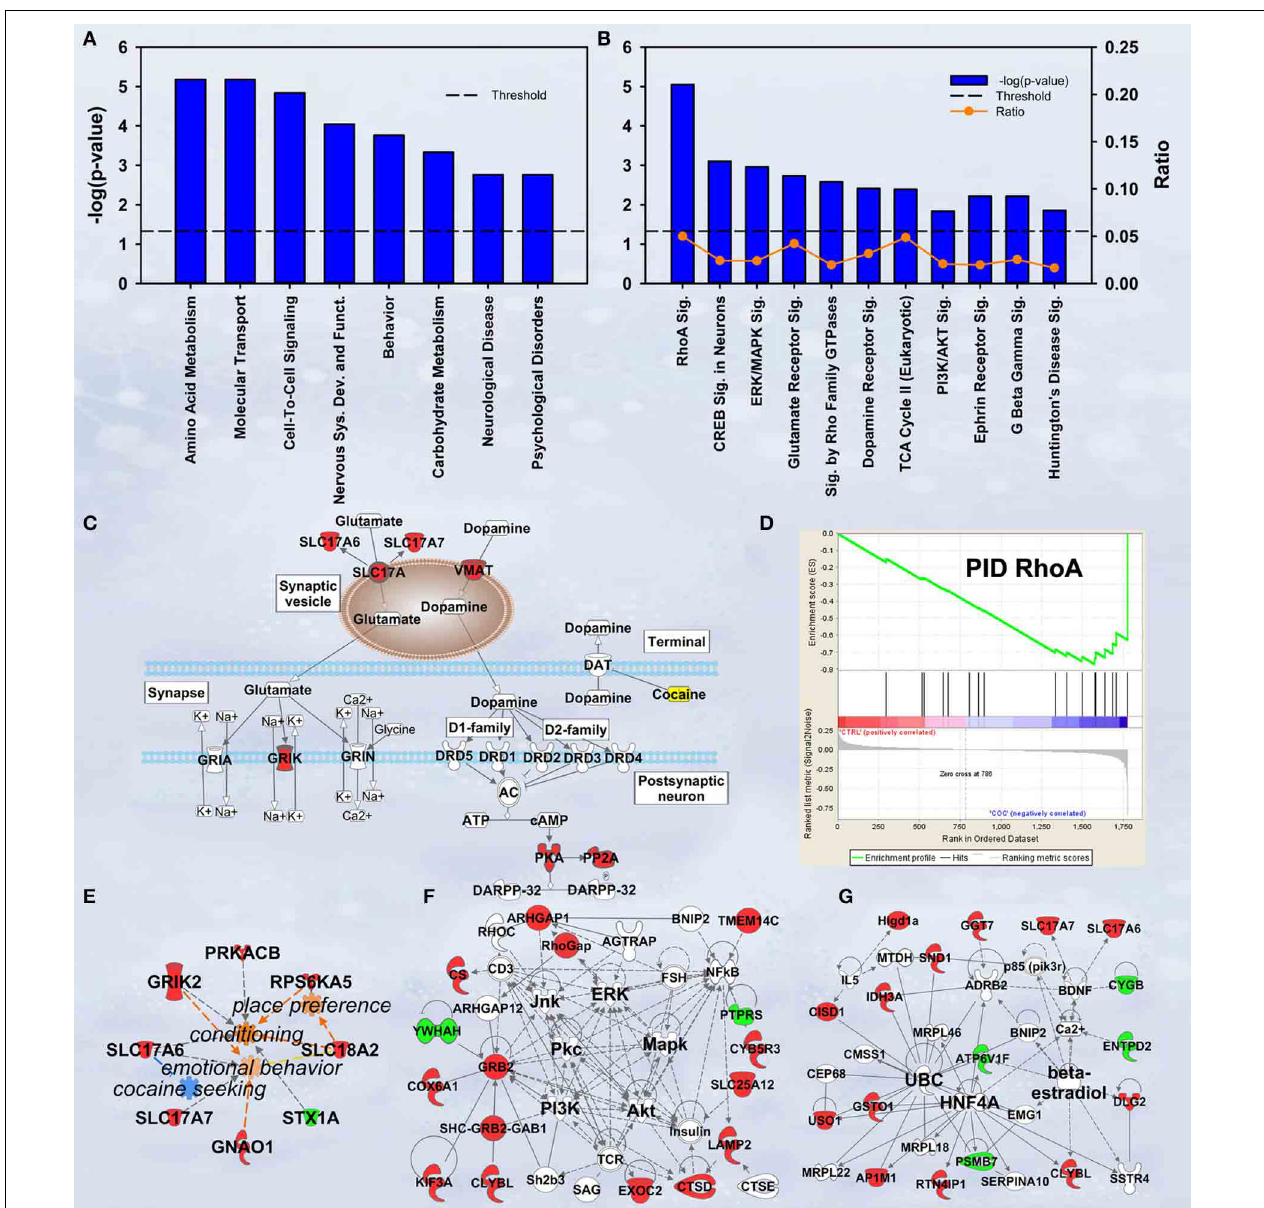
FIGURE 1 | IPA and GSEA findings for cocaine main effect. A complete list of results can be found in Supplementary Materials, as can a complete list of all proteins in each pathway. (A) A selection of significant biological functions and diseases for cocaine main effect as determined by IPA. The y axis represents the − log( p -value) for each function/disease. (B) A selection of significant canonical pathways for cocaine main effect, as determined by IPA. Orange line represents a ratio of regulated proteins to all proteins in the pathway. (C) Combined glutamate and dopamine signaling pathways. Proteins whose expression levels were significantly increased are highlighted in red. SLC17A: vesicular glutamate transporter. GRIK: glutamate receptor (kainate). (D) GSEA plot demonstrating enrichment of proteins associated with the Protein Interaction Database’s ras homolog family member A (RhoA) pathway. Protein regulation is ranked from those with highest correlation of expression to saline rats to the left to those with the highest correlation of expression in cocaine rats to the right. Vertical black tick marks represent